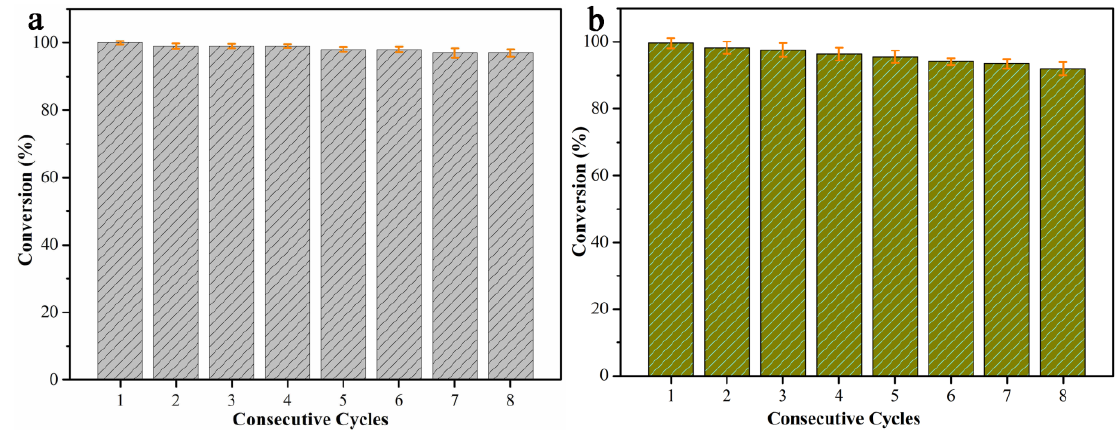
/ PCL@PdNPs catalyst for the reduction of 4-NP ( a ) and 2-NA ( b Figure 9. Recyclability test of PEI/PCL@PdNPs catalyst for the reduction of 4-NP ( a ) and 2-NA ( b ). Figure 9. Recyclability test of PEI